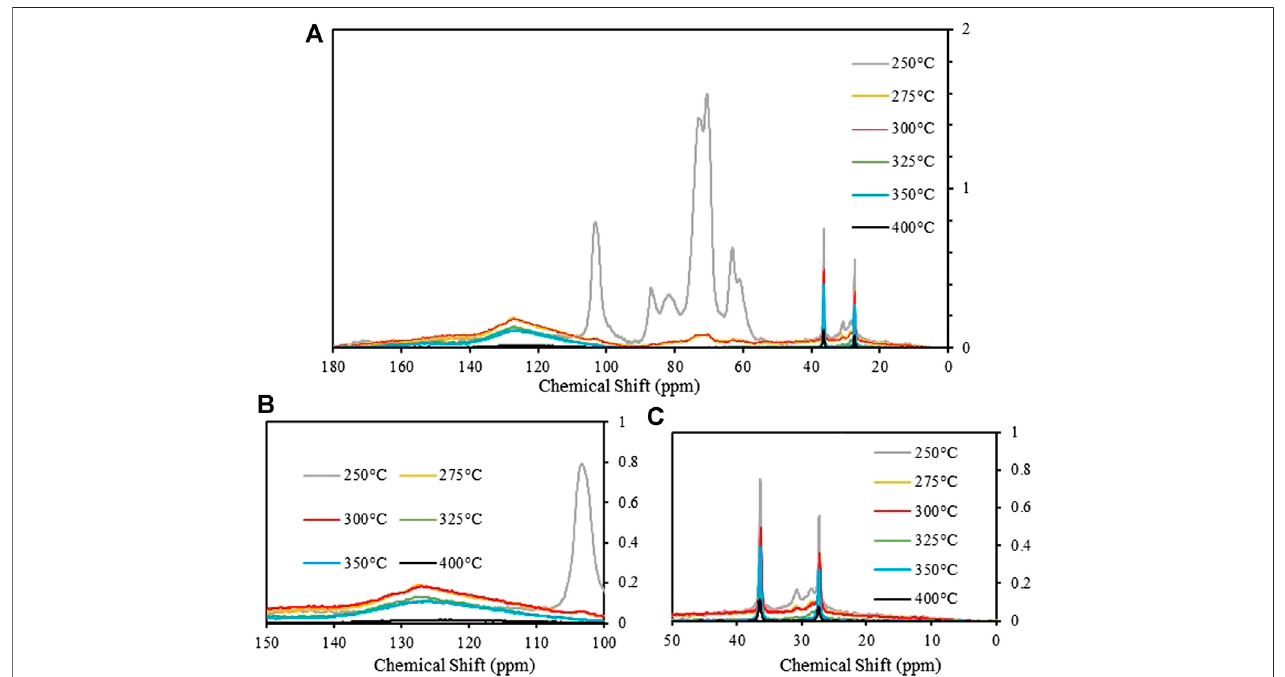
FIGURE 3 | (a) 13 C{ 1 H} CP/MAS NMR spectrum of torre fi ed paper at temperatures from 200 – 400 ° C showing asymmetric degradation of carbon species at increasing temperatures; (b) 13 C{ 1 H} CP/MAS NMR spectrum of torre fi ed paper centered around 127 ppm showing degradation of aromatic carbon throughout the temperatureregime; (c) 13 C{ 1 H}CP/MASNMRspectrumoftorre fi edpaperinthealiphaticregionshowingthermaldecompositionofpeakat31 ppm.Thepeaksat36.5 and 27.4 ppm are from the adamantane standard used for peak normalization.